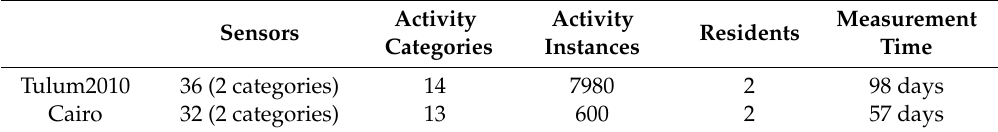
Table 2. Statistical information concerning datasets “Tulum2010” and “Cairo.”.